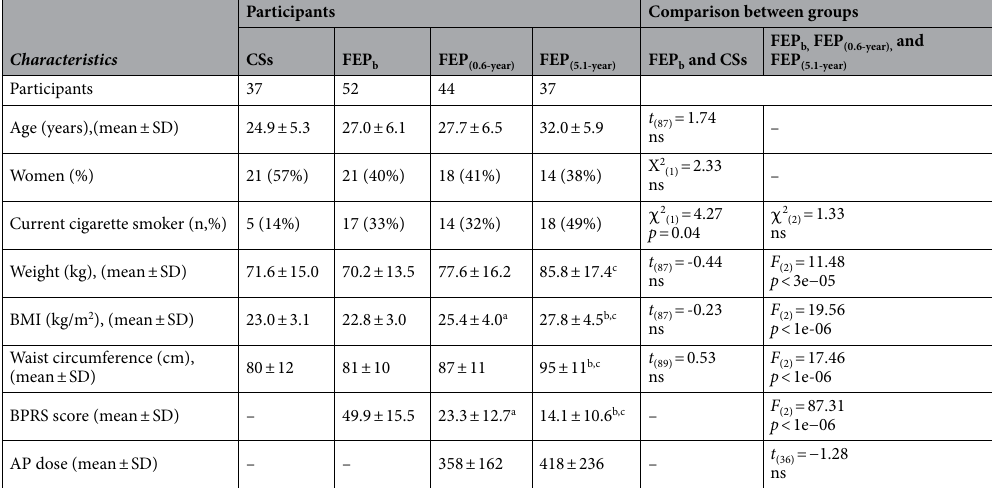
Table 1. Characteristics of control subjects (CSs) and first-episode psychosis (FEP) patients at baseline (before treatment with antipsychotics (FEP b ), after 0.6-year treatment (FEP 0.6-year ), and after 5.1-year treatment (FEP 5.1-year ) with antipsychotics. BMI body mass index, BPRS Brief Psychiatric Rating Scale, AP dose chlorpromazine equivalent dose of antipsychotics. ns not significant ( p ≥ 0.05). a Statistically significant difference ( p < 0.05) between patients before (FEP b ) and after 0.6-year treatment (FEP (0.6-year) ). b Statistically significant difference ( p < 0.05) between 0.6-year (FEP (0.6-year) ) and 5.1-year treatment (FEP (5.1-year) ). c Statistically significant difference ( p < 0.05) between patients before (FEP b ) and after 5.1-year treatment (FEP (5.1-year)